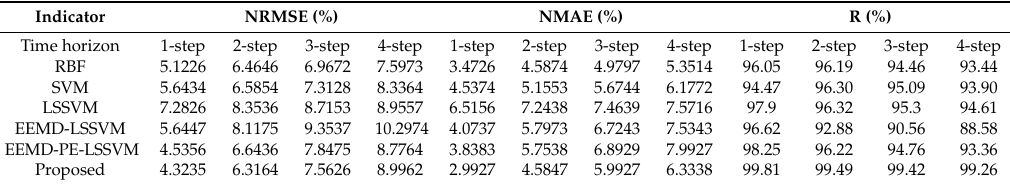
Table 5. The values of NRMSE, NMAE and R for six models in Dataset B.